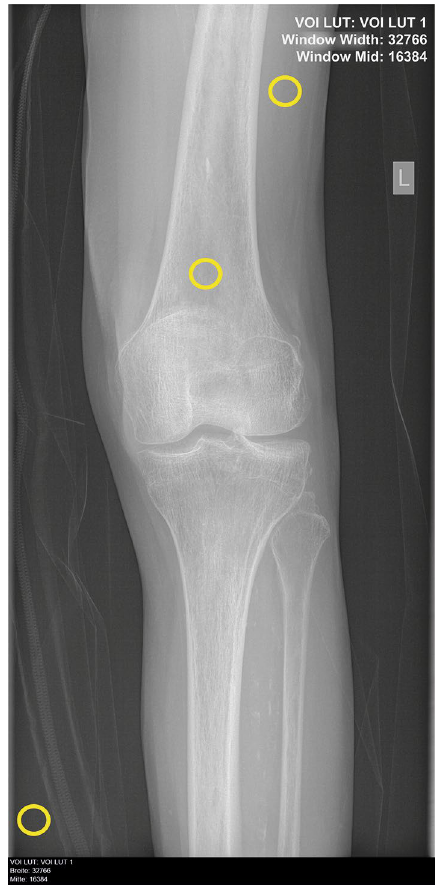
Figure 8. Location of ROIs for quantitative analysis. Target ROI = Trabecular bone, Reference ROI = Soft tissue, Background ROI = Background